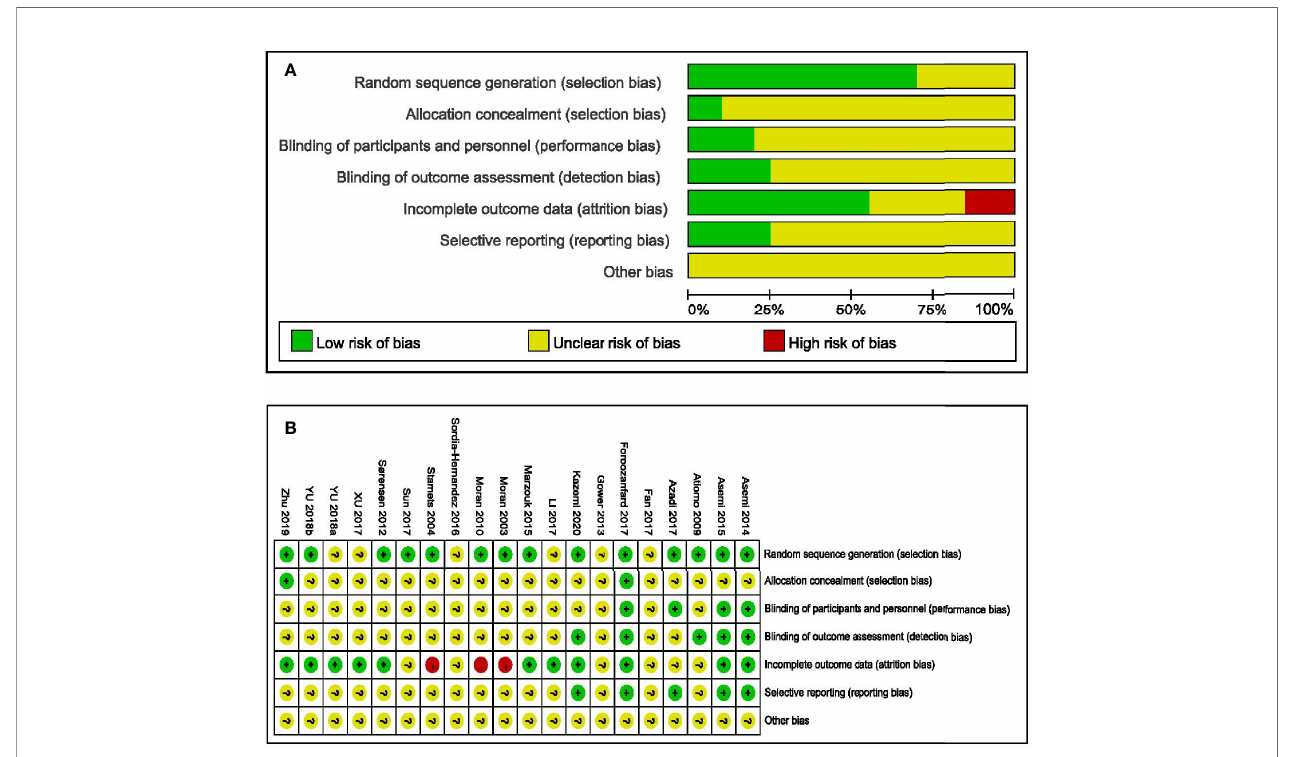
FIGURE 2 | Assessments about risk-of-bias of included studies. (A) Risk of bias graph and (B) Risk of bias